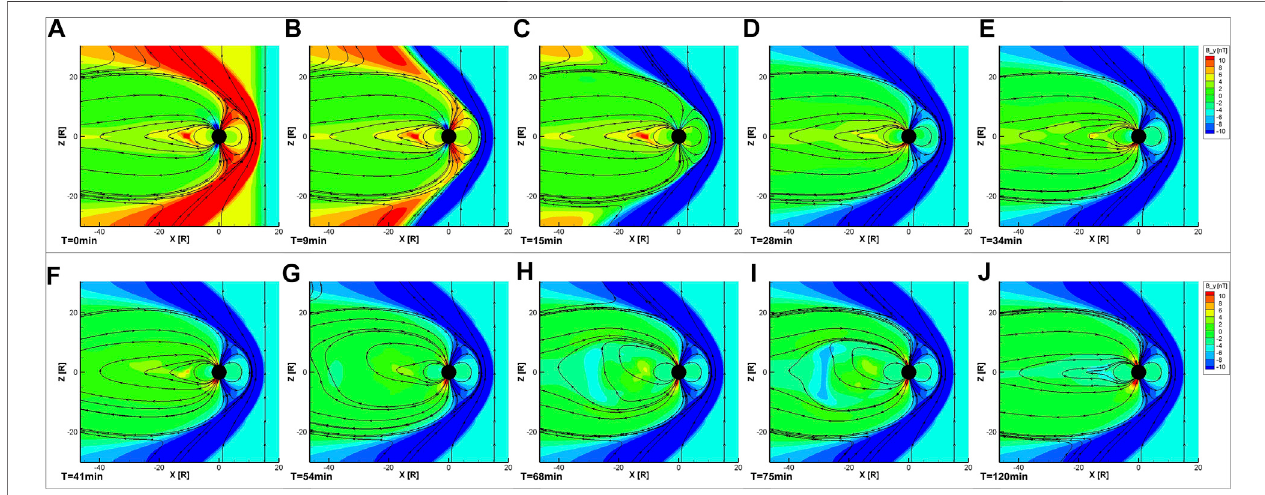
FIGURE 1 | Global magnetospheric con fi guration in the XZ plane. Color indicates B y component. The black streamlines represent magnetic fi eld lines.